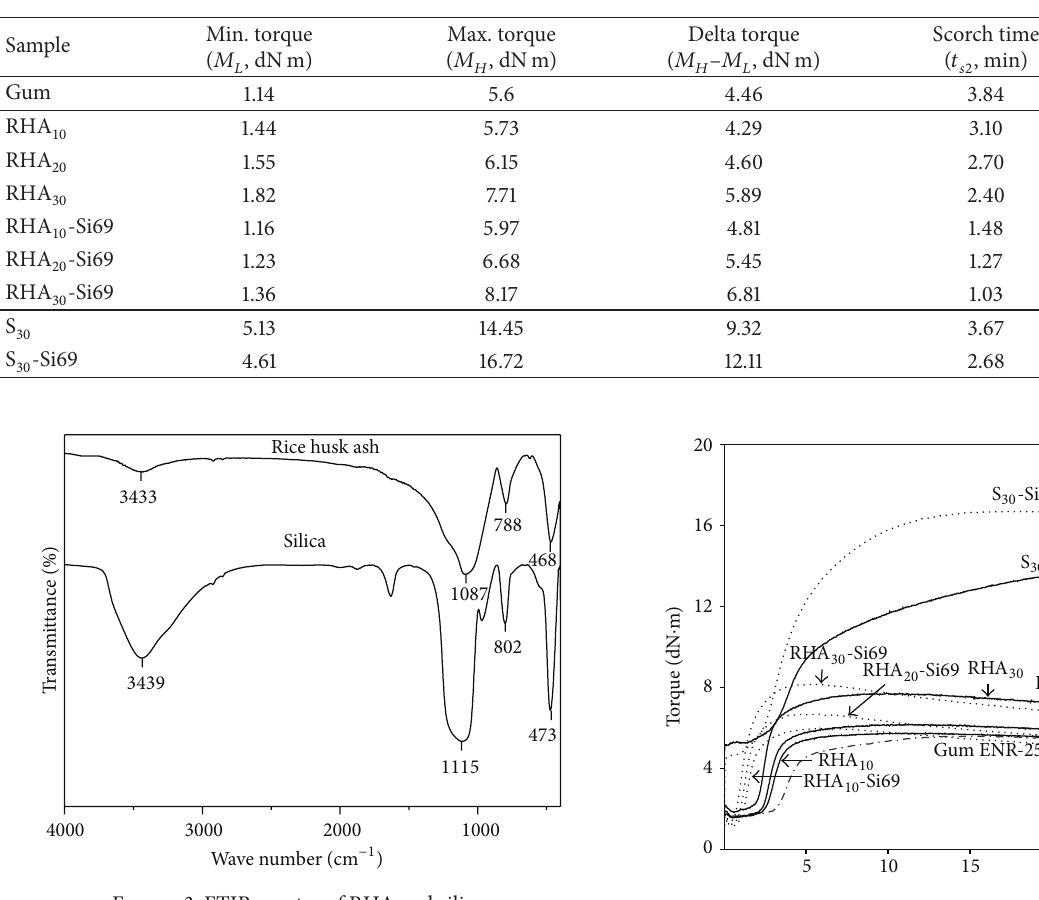
Figure 3: FTIR spectra of RHA and silica.